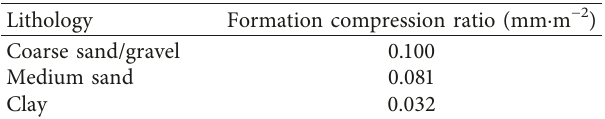
Table 4: Prediction of formation compression ratio of industrial plaza in the Zhuxianzhuang Coal